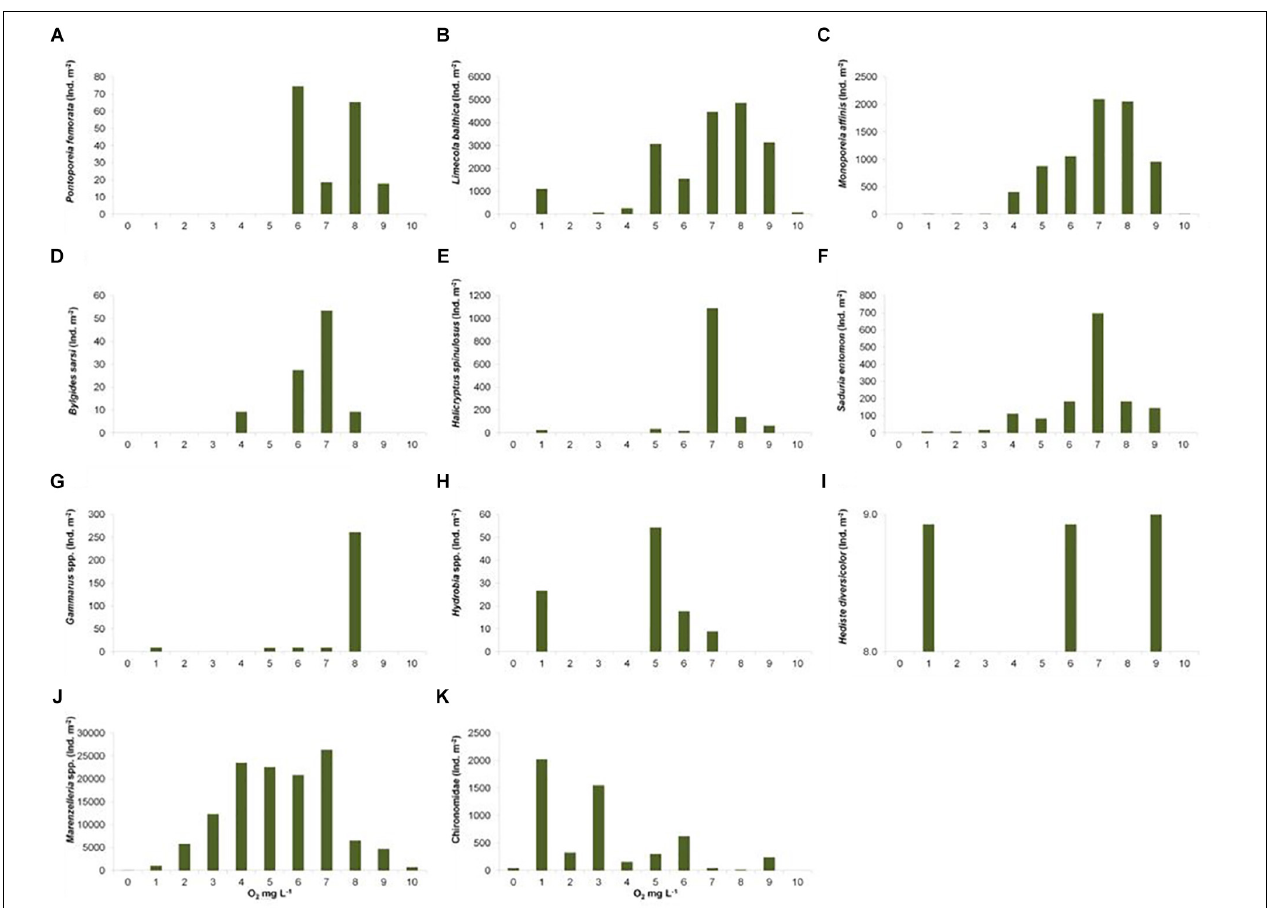
FIGURE 6 | Total sum of studied taxa ind. m − 2 ( y -axis) in distinct categories of O 2 mg L − 1 ( x -axis). (A) Pontoporeia femorata , (B) Limecola ( Macoma ) balthica , (C) Monoporeia affinis , (D) Bylgides sarsi , (E) Halicryptus spinulosus , (F) Saduria entomon , (G) Gammarus spp., (H) Hydrobia spp., (I) Hediste diversicolor , (J) Marenzelleria spp., (K) Chironomidae.